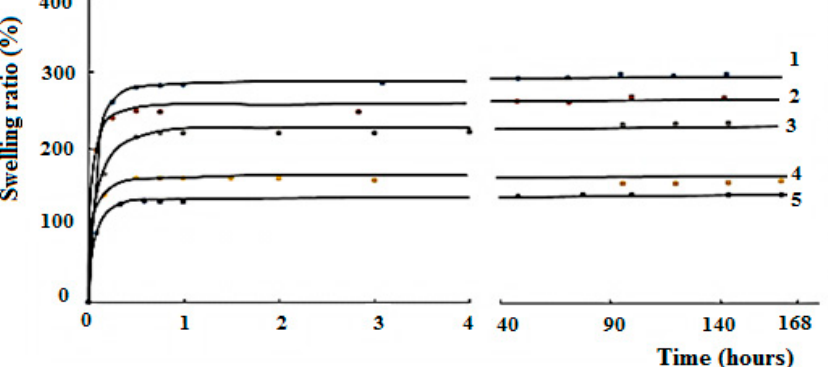
Figure 7. Swelling kinetics of chitosan hydrochloride/citrus pectin hydrogels in distilled water. Chitosan hydrochloride conc. 8% (1, 2) or 4% (3–5), citrus pectin conc. 2% (1, 3, 4) or 1% (2, 5), molar ratio chitosan/pectin 1:1 (1–3, 5) or 1:2 (4). Data are expressed as mean ± SD; n = 3.